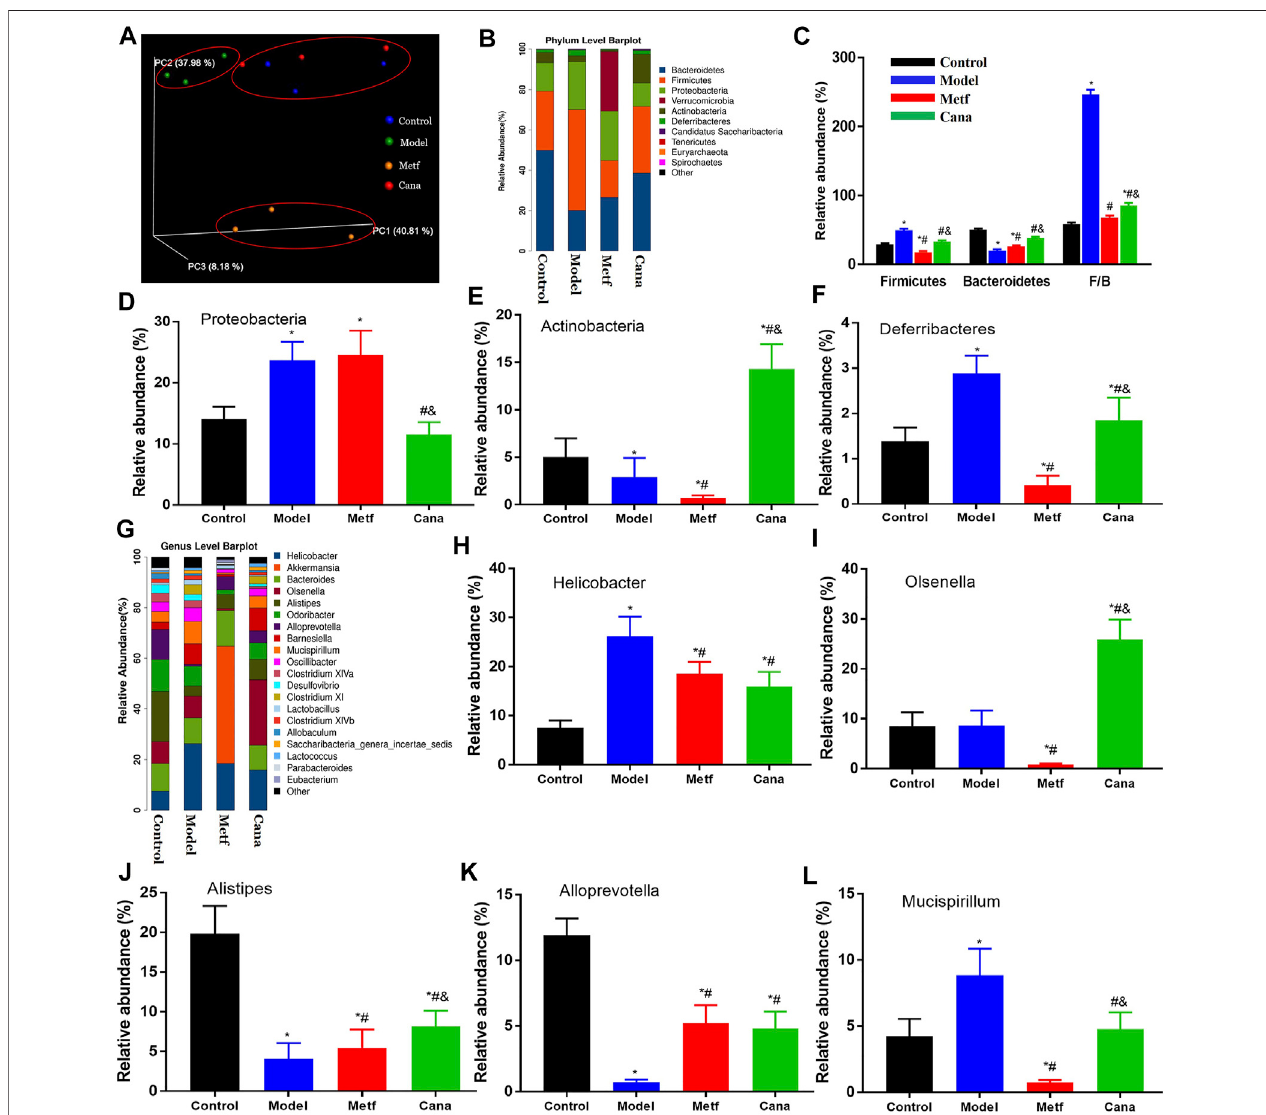
FIGURE 5 | Modulation of microbiota by Cana treatment. PCoA plot of microbiota (A) . Abundance at the phylum level (B) , including Bacteroidetes and Firmicutes (C) ,Proteobacteria (D) ,Actinobacteria (E) ,and Deferribacteres (F) invariousgroups.Abundanceatthegenuslevel (G) ,including Helicobacter (H) , Olsenella (I) , Alistipes (J) , Alloprevotella (K) , and Mucispirillum (L) . Data are expressed as mean ± SEM. & p < 0.05, the Cana group compared with the Metf group; # p < 0.05, compared with the model group; * p < 0.05, compared with the control group. Three mice in each group were randomly selected for